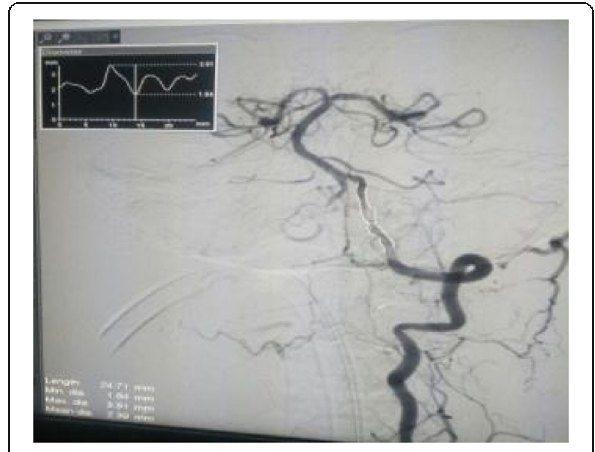
Fig. 1 Diagnostic phase for one of our patient showed Lt vertebro- basilar (VB) stenosis